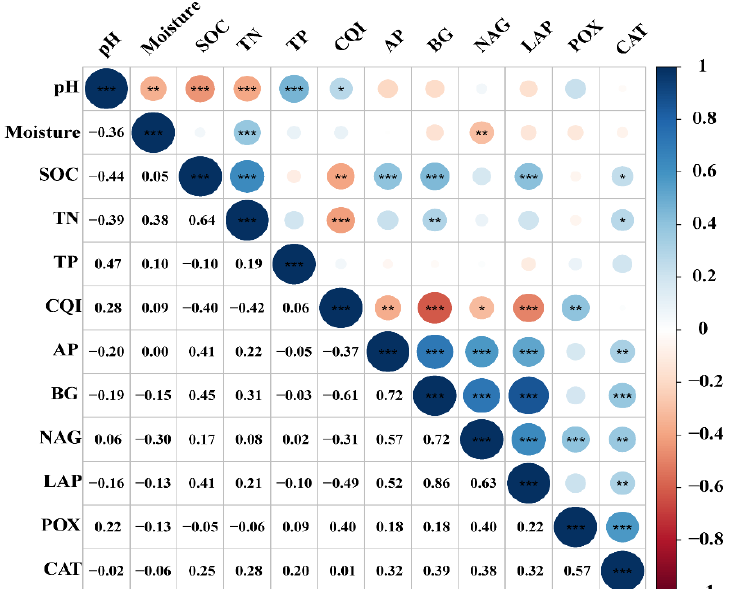
Figure 4. Pearson correlation analysis of soil physicochemical properties and enzyme activities in Wuzhishan National Nature Reserve. Blue represents a positive correlation and red represents a negative correlation. A darker color means a stronger correlation between the two variables and a lighter color means a weaker or no correlation between the two variables. Significance: * indicates p < 0.05, ** indicates p < 0.01, *** indicates p <